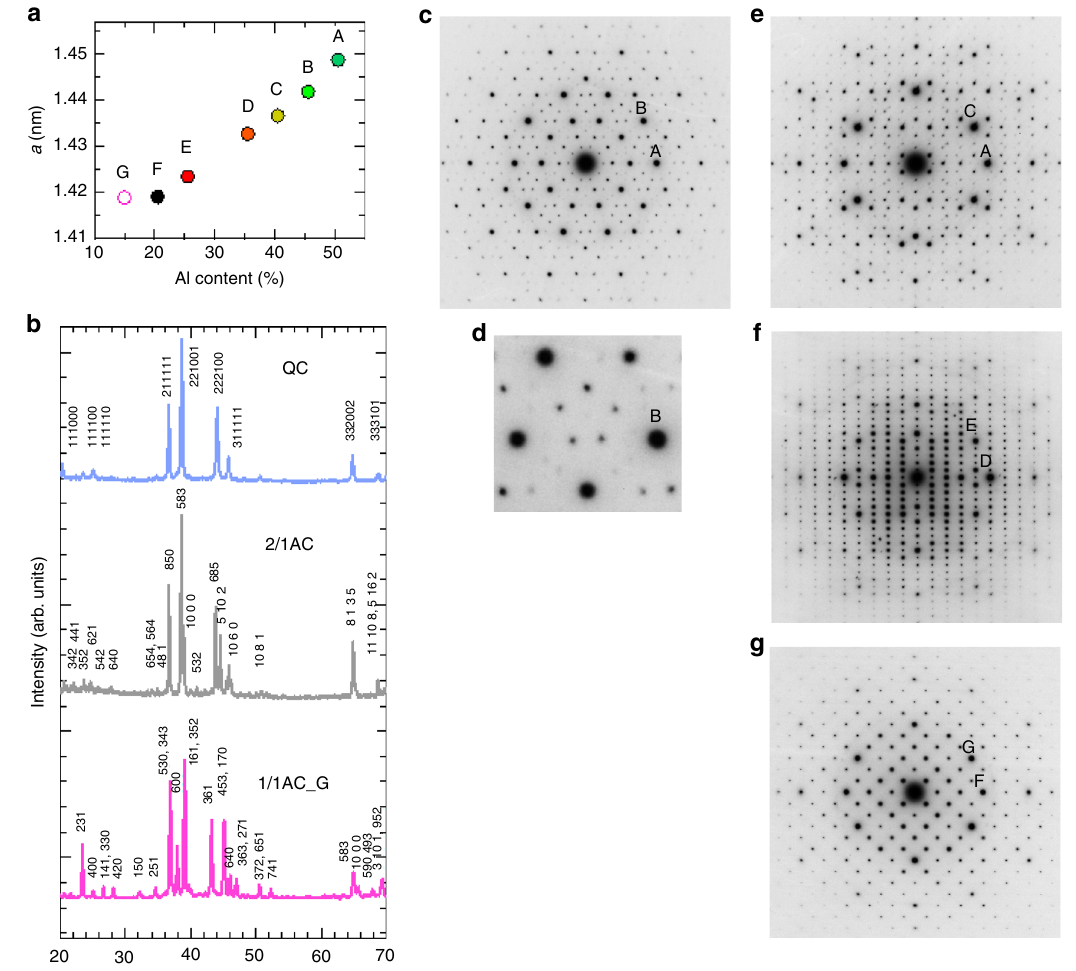
Fig. 3 Diffraction patterns. a Lattice parameter a of 1/1AC samples determined from X-ray diffraction method as a function of Al content. Note that a decreases almost linearly with Al content. b Representative X-ray diffraction patterns of the QC, the 2/1AC, and the 1/1AC_G. Note that six integers are needed to index the peak of the QC. c , d Fivefold electron diffraction patterns of the QC. Magni fi ed image ( d ) shows deviation from the perfect regular pentagon for weaker re fl ections. e Twofold electron diffraction pattern of the QC. f , g Electron diffraction patterns of 2/1 and 1/1AC with the incident beam along each [001]